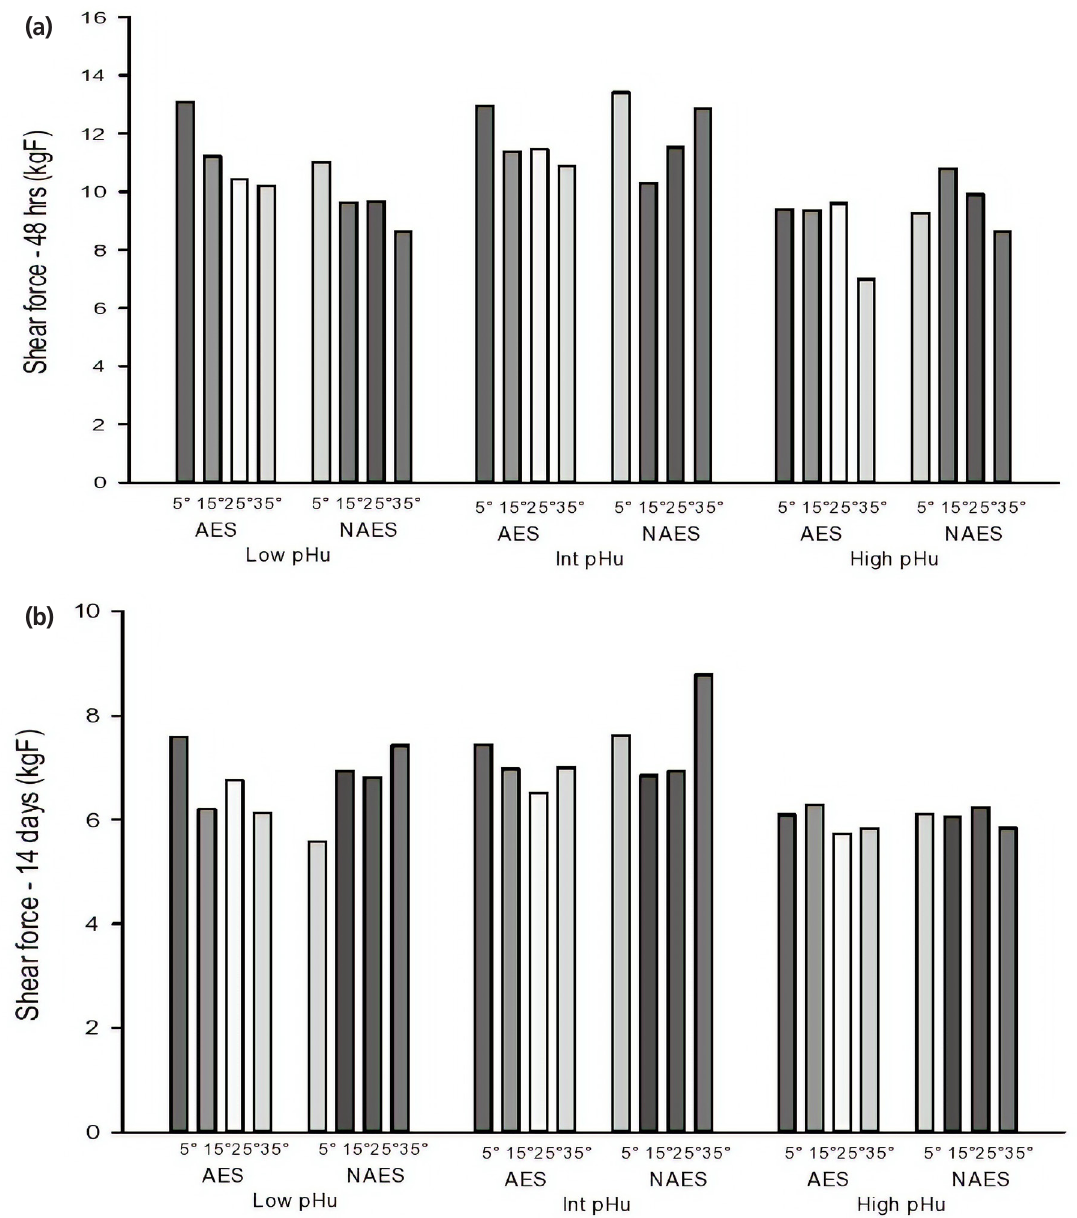
Figure 3. (a) Effect of AES and various pre-rigor holding temperature (for 3 h) methods on shear force (48 h post mortem) of low, intermediate and high pHu beef M. longissimus lumborum samples. AES, additional electrical stimulation; NAES, no additional electrical stimulation. Low pHu (n = 3), Int (intermediate) pHu (n = 3), and high pHu (n = 6). Treatment effect [AES vs ES] (p>0.05); pH effect (p>0.05); temperature effect (p = 0.046); interaction effect (p>0.05, standard error of difference [SED] = 1.76). (b) Effect of AES and various pre-rigor holding temperature (for 3 h) methods on shear force (14 days post mortem) of low, intermediate and high pHu beef samples. Low pHu (n = 3), Int (intermediate) pHu (n = 3), and high pHu (n = 6). Treatment effect [AES vs ES] (p>0.05); pH effect (p>0.05); temperature effect (p>0.05); interaction effect (p>0.05, SED =